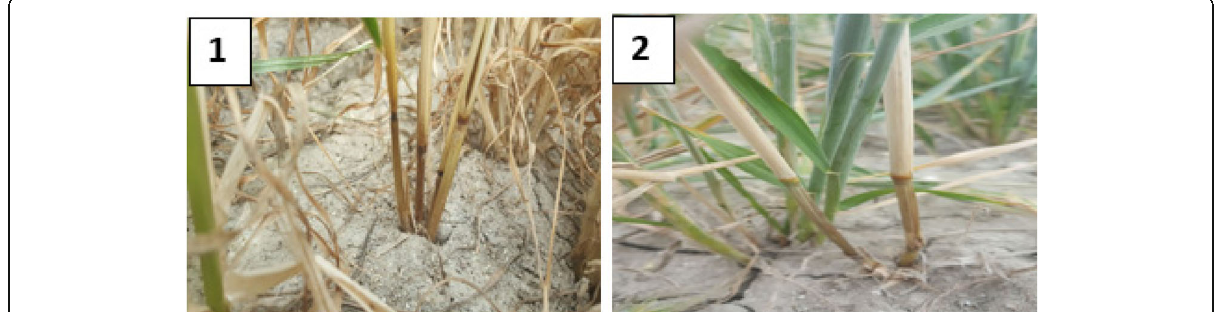
Fig. 2 Fusarium crown rot (FCR) symptoms at ripening time in 1 Talha (HM) and 2 Thagar (TI2) wheat